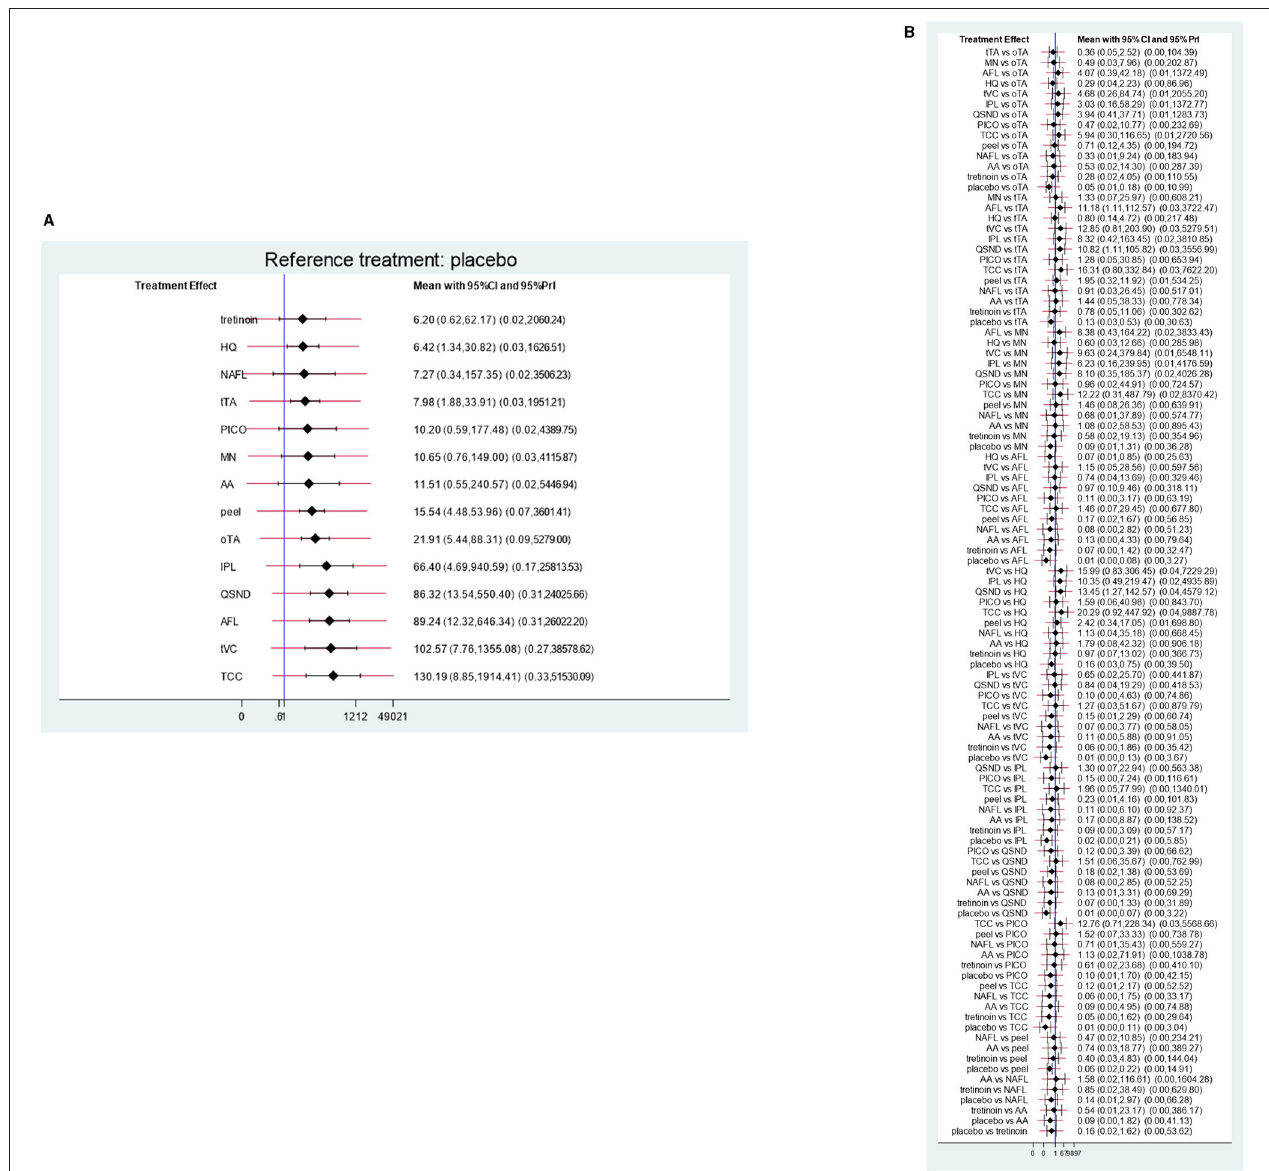
FIGURE 5 | Direct comparisons. (A) Direct comparisons with placebo for each treatment; (B) direct comparisons for all